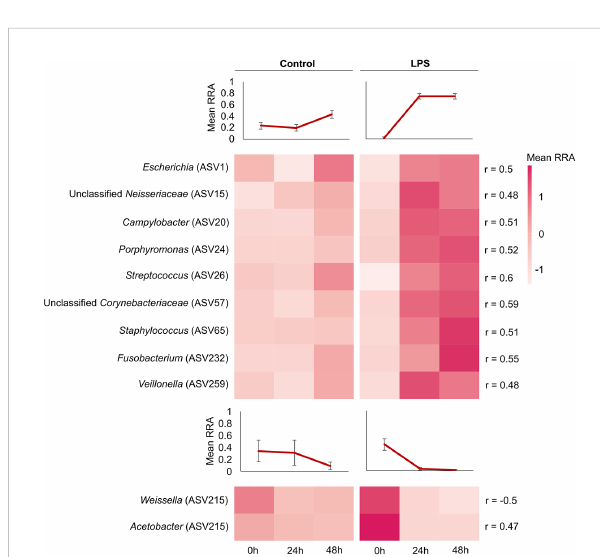
FIGURE 3 Bacterial ASVs that correlated with the strength of the immune response (haptoglobin concentration) in bats. Matrices show the relative read abundance (RRA) of amplicon sequence variants (ASVs) that correlated with haptoglobin concentrations, at different sampling time points. Only ASVs that presented signi fi cant Spearman r values ( p adjust value < 0.05) with haptoglobin are presented and their r value is shown on the right. Positive correlations appear at the top of the graph and negative correlations appear at the bottom. The color scale represents the RRA of each ASV. Mean RRA values of ASVs in each time point (line graphs) are presented above each block (control bats – positive and negative correlations, challenged bats – positive and negative correlations). LPS, lipopolysaccharides. Each ASV genus af fi liation (where possible) is denoted next to the ASV numbers on the